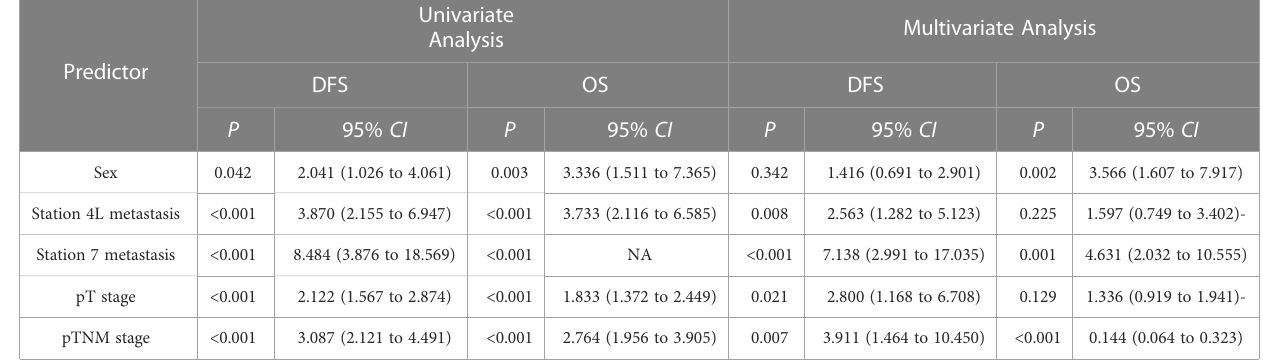
TABLE 4 Univariate and multivariate Cox regression analysis of prognostic factors in the SCC and ADC groups.